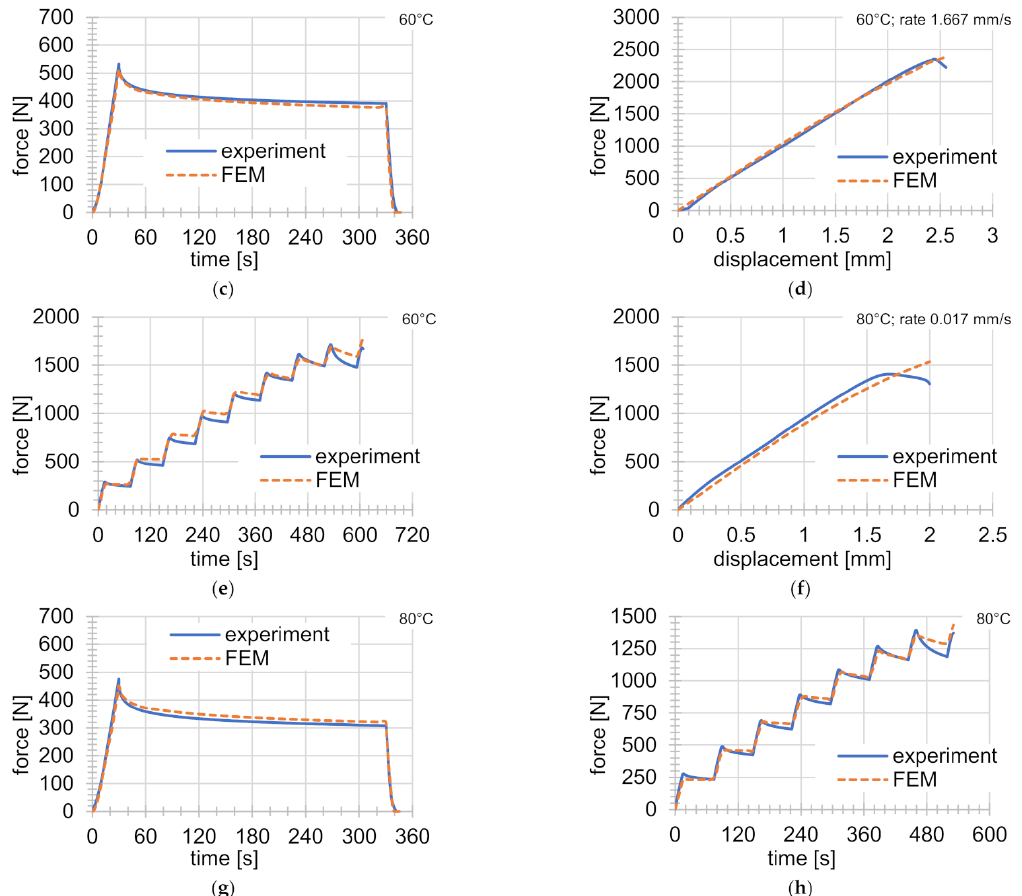
Figure 5. Comparison of experiments with FEM solutions (continuation): ( a ) tensile test at 60 ◦ C and rate of deformation of 0.017 mm s − 1 ; ( b ) tensile test 60 ◦ C and rate of deformation of 0.167 mm s − 1 ; ( c ) indentation test at 60 ◦ C; ( d ) tensile test at 60 ◦ C and rate of deformation of 1.667 mm s − 1 ; ( e ) graded tensile test at 60 ◦ C; ( f ) tensile test at 80 ◦ C and rate of deformation of 0.017 mm s − 1 ; ( g ) indentation test at 80 ◦ C; ( h ) graded tensile test at 80 ◦